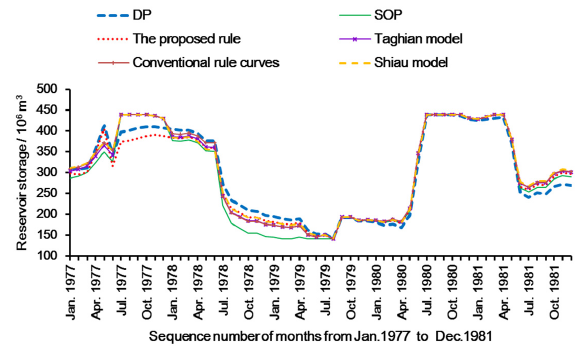
Figure 15. The end-of-month reservoir storage levels obtained using dynamic programming (DP) and the other scenarios during the critical periods from 1977 to 1981.